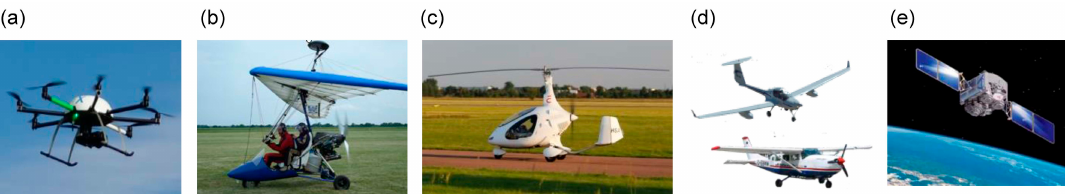
Figure 1. Different air- and spaceborne remote sensing platforms for assessing geomorphological landforms and their traits: ( a ) unmanned aerial vehicles (UAVs) or drones, ( b ) microlight-gravity-controlled aircrafts ( c ) gyrocopter-microlight helicopter, ( d ) ECO-Dimona aircraft (top) and Cessna aircraft (bottom), and ( e ) satellite (from Lausch et al. [3]).